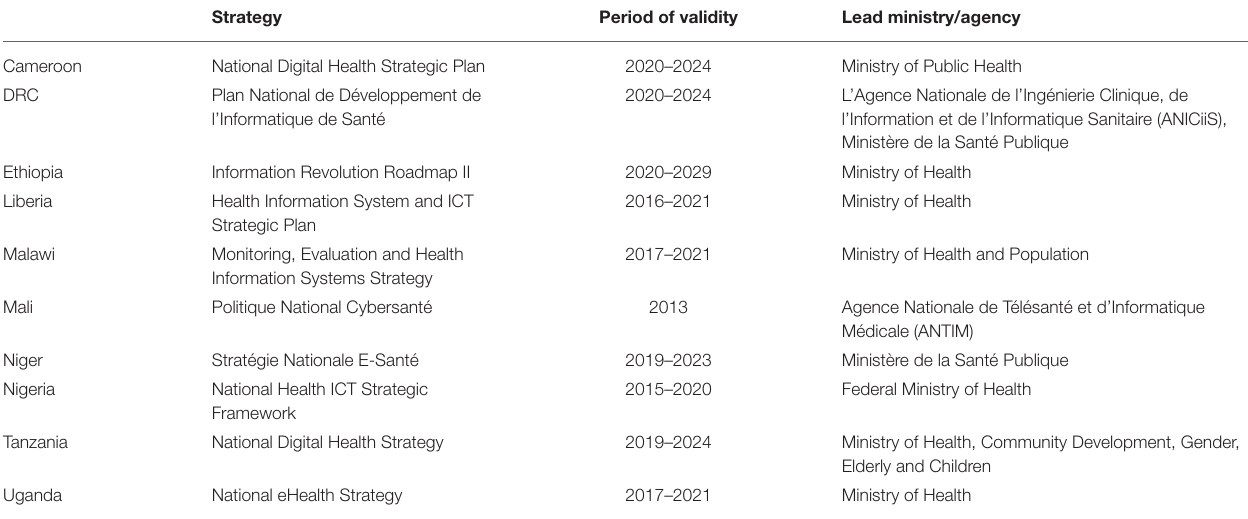
TABLE 2 | Overview of digital health